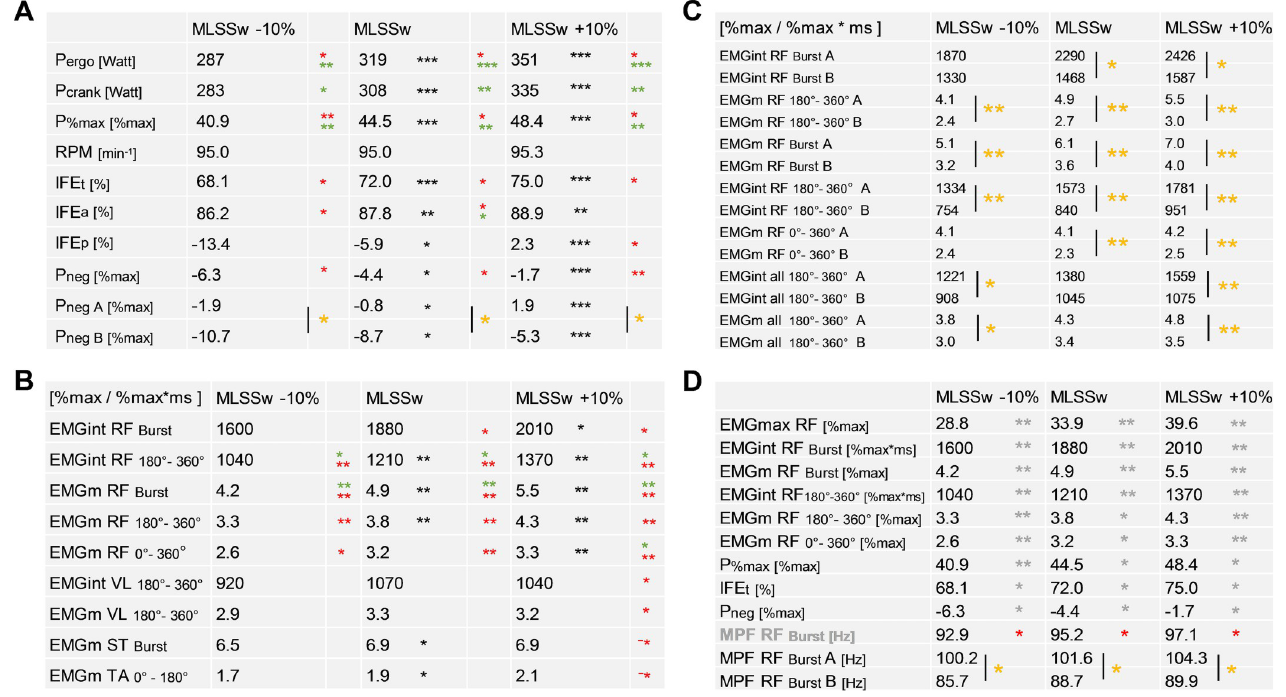
Fig 1. Time synchronized force and EMG data in CP-tests. Results are shown for MLSSw - 10%, MLSSw, and MLSSw + 10% (A-D) . (A) Correlation of mechanical parameters to MLSSw and MLSSw/kg (n = 14). Except for cadence (RPM), all parameters differ between workloads. Negative force is lower in group A. (B) Correlation of muscle activity to MLSSw and MLSSw/kg (n = 14). Only RF activity consistently differs between workloads and correlates to MLSSw and MLSSw/kg. The only exception is the VL at MLSSw + 10%. Note the negative correlation for ST and TA to MLSSw/kg at the same workload. (C) RF activity and correlation to MLSSw and MLSSw/kg at different workloads for group A and B (both groups n = 7). RF activity but also mean EMGs of all 4 muscles were consistently increased especially in the posterior part of the pedal cycle in group A compared to group B. (D) Correlation of frequency parameters (MPF) to IFEt, P%max, Pneg and EMG RF (n = 14). Note the pronounced MPF of RF in group A, which likely increases the quantitative amount of neural drive and, thus, the contractile force. P%max and Pneg are shown as mean of both cranks. IFE(t,a,p) is shown as mean of the right crank. For detailed description of data analysis and parameter definitions see Methods and S1 Fig. Black asterisks ( � ): two-tailed paired t-tests (A,B) , yellow asterisks ( � ): two-tailed unpaired t-tests (A,C,D) , red asterisks ( � ): correlation to MLSSw/kg (A,B,D) , green asterisks ( � ): correlation to MLSSw (A,B) , grey asterisks ( � ): correlation of MPF RF Burst to mechanical parameters and quantitative RF activity (D) . Shown is mean. � P < 0.05, �� P < 0.01, ��� P <